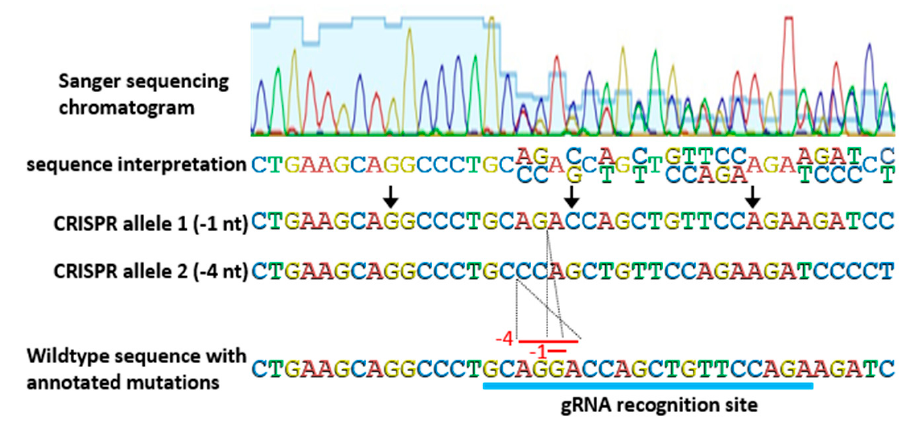
Figure 4. Determining sequences of bi-allelic PCR products directly from Sanger sequencing chro- matograms. The chromatogram shows a zoom-in of the relevant portion of a longer Sanger sequenc- ing product. Sanger sequencing chromatograms display the four DNA nucleotides as peaks of dif- ferent colors and when multiple peaks are shown at the same position (overlapping), it indicates a bi-allelic PCR product. Sequence interpretation from such a convoluted chromatogram is still pos- sible, as each position with overlapping peaks can be assigned two bases at that position, corre- sponding to the two DNA sequences in the PCR product. Because CRISPR most typically results in small deletions, examining the sequence interpretation for occurrence of the wildtype sequence al- lows each position to be defined for one allele. Direct interpretation of CRISPR-derived mutations in biallelic PCR products avoids the time and expense of subcloning.